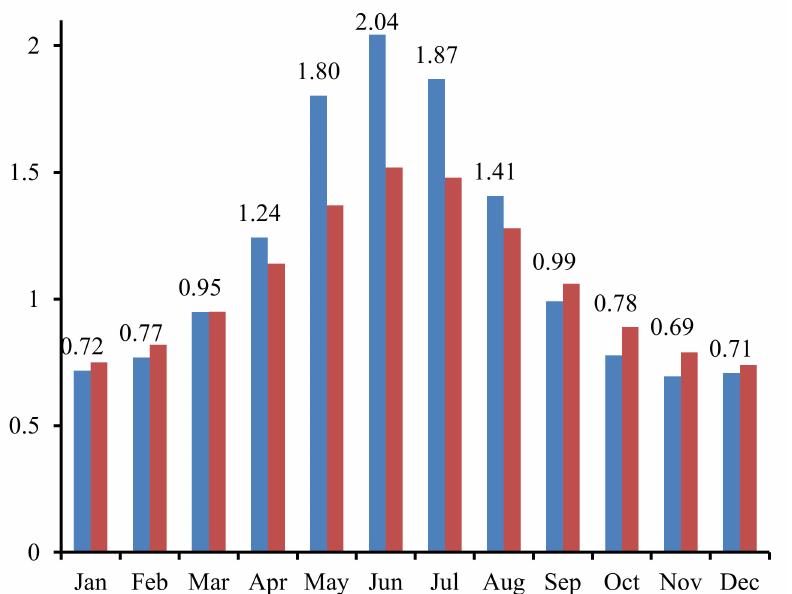
Figure 6. Seasonal correction factors for three-months measurements. Blue bars—Nizhny Novgorod (with indication of the value); red bars—the UK